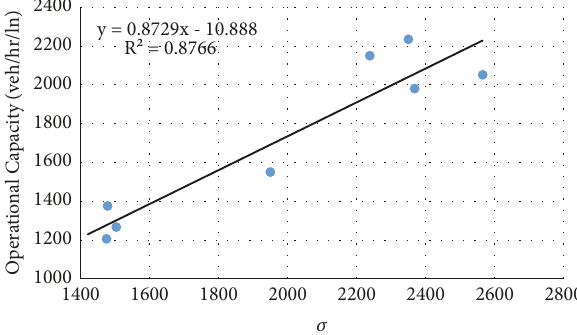
Figure 2: Relationship between the scale parameter and the opera- tional capacity.